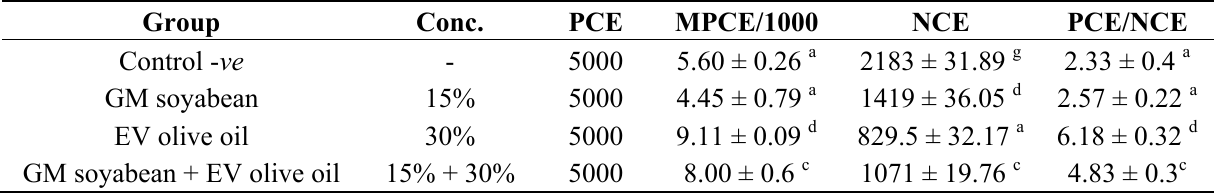
Table 5. Effect of E.V. olive oil and G.M. soyabean on percentage of nucleated polychromatic erythrocytes (MPCE) and PCE/NCE ratio in rats ( n = 10). Significant at p < 0.05 using ANOVA test a, b, c,… Significantly different between two comparison groups within the same litter and column using Duncan Multiple Range test at p <